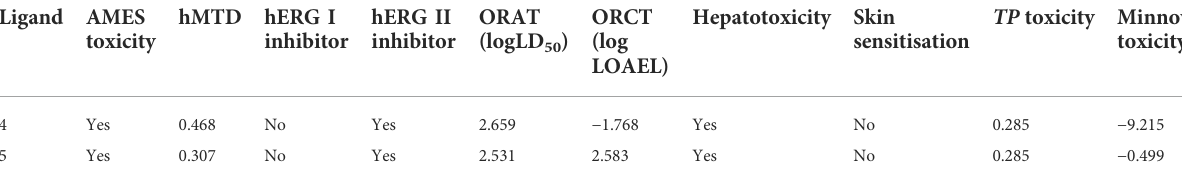
The red colour indicates that the ligand does not meet the criteria of the corresponding parameter.